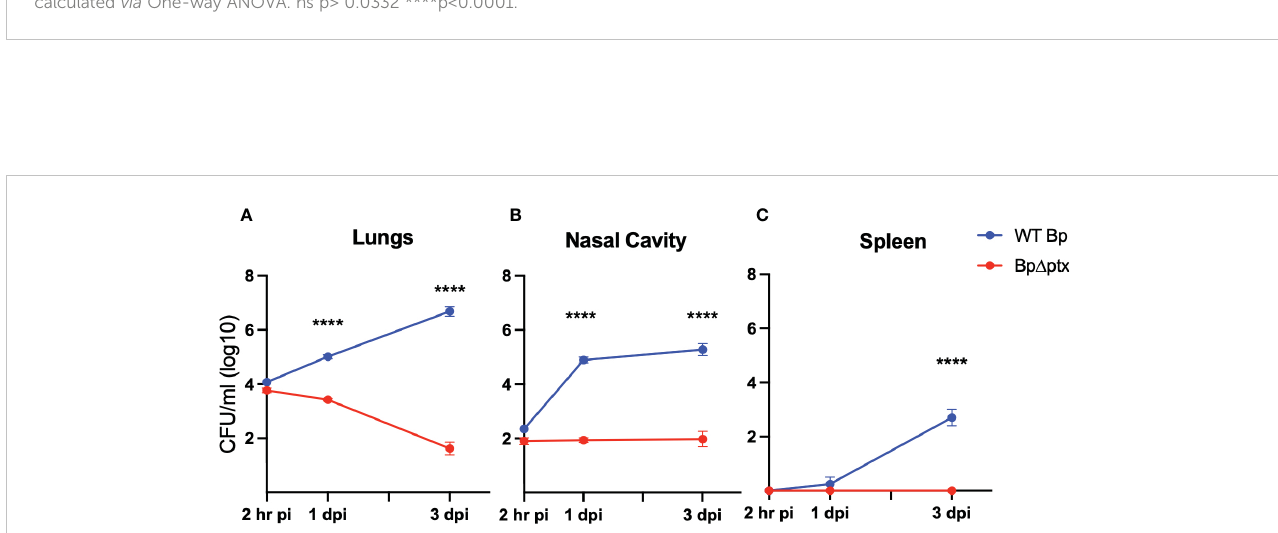
FIGURE 3 Pertussis toxin (PTx) is required for infection of P5 neonatal mice. Log10 of CFU recovered from the lungs (A) nasal cavity (B) and spleen (C) at 2 hours, 1, and 3 days post inoculation from neonatal C57BL/6J mice inoculated at P5 with either WT B . pertussis (blue) or B . pertussis D ptx (red) (n=4 per strain per timepoint). Statistical signi fi cance was calculated via Two-way ANOVA. Error bars show the standard error of the mean. ns p> 0.0332,